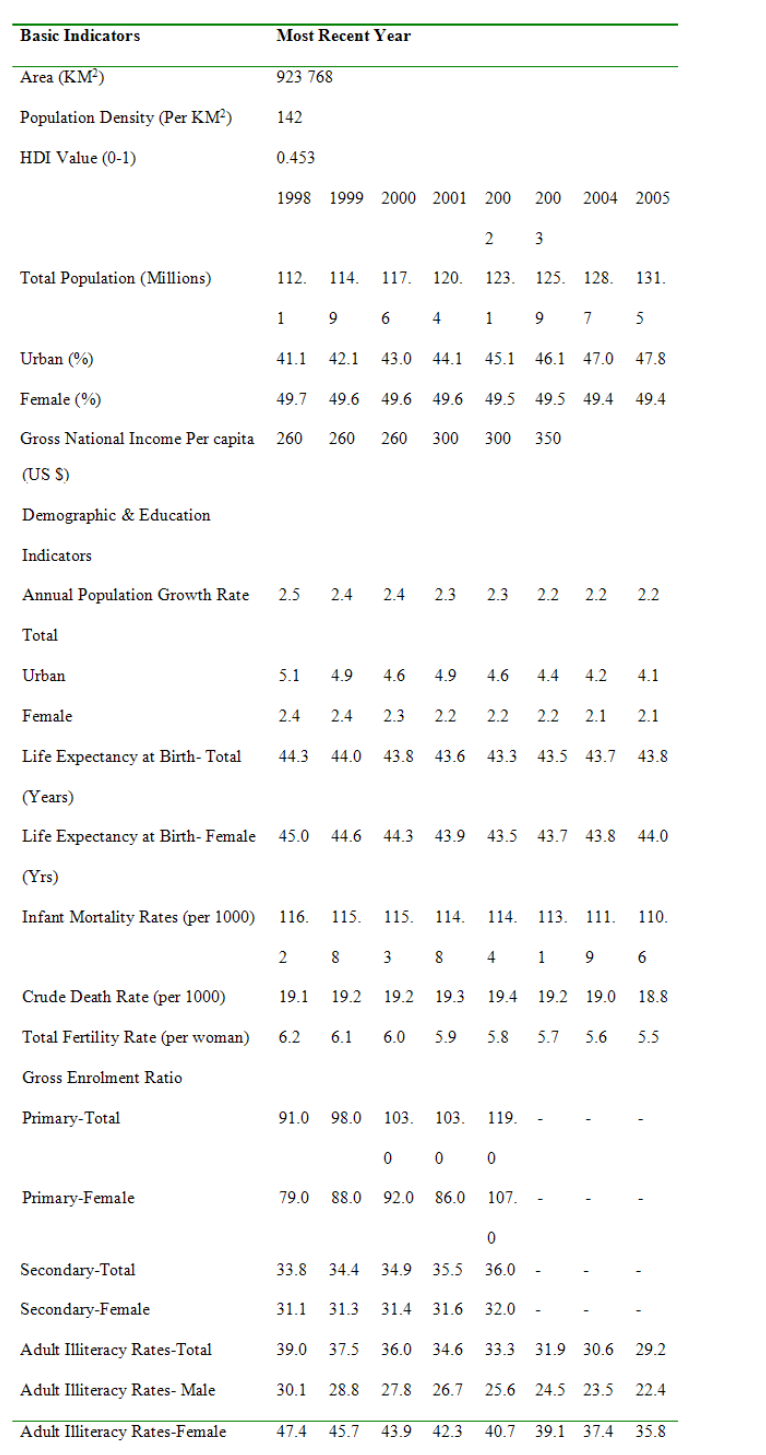
Table 2. Selected basic demographic and education indicators for